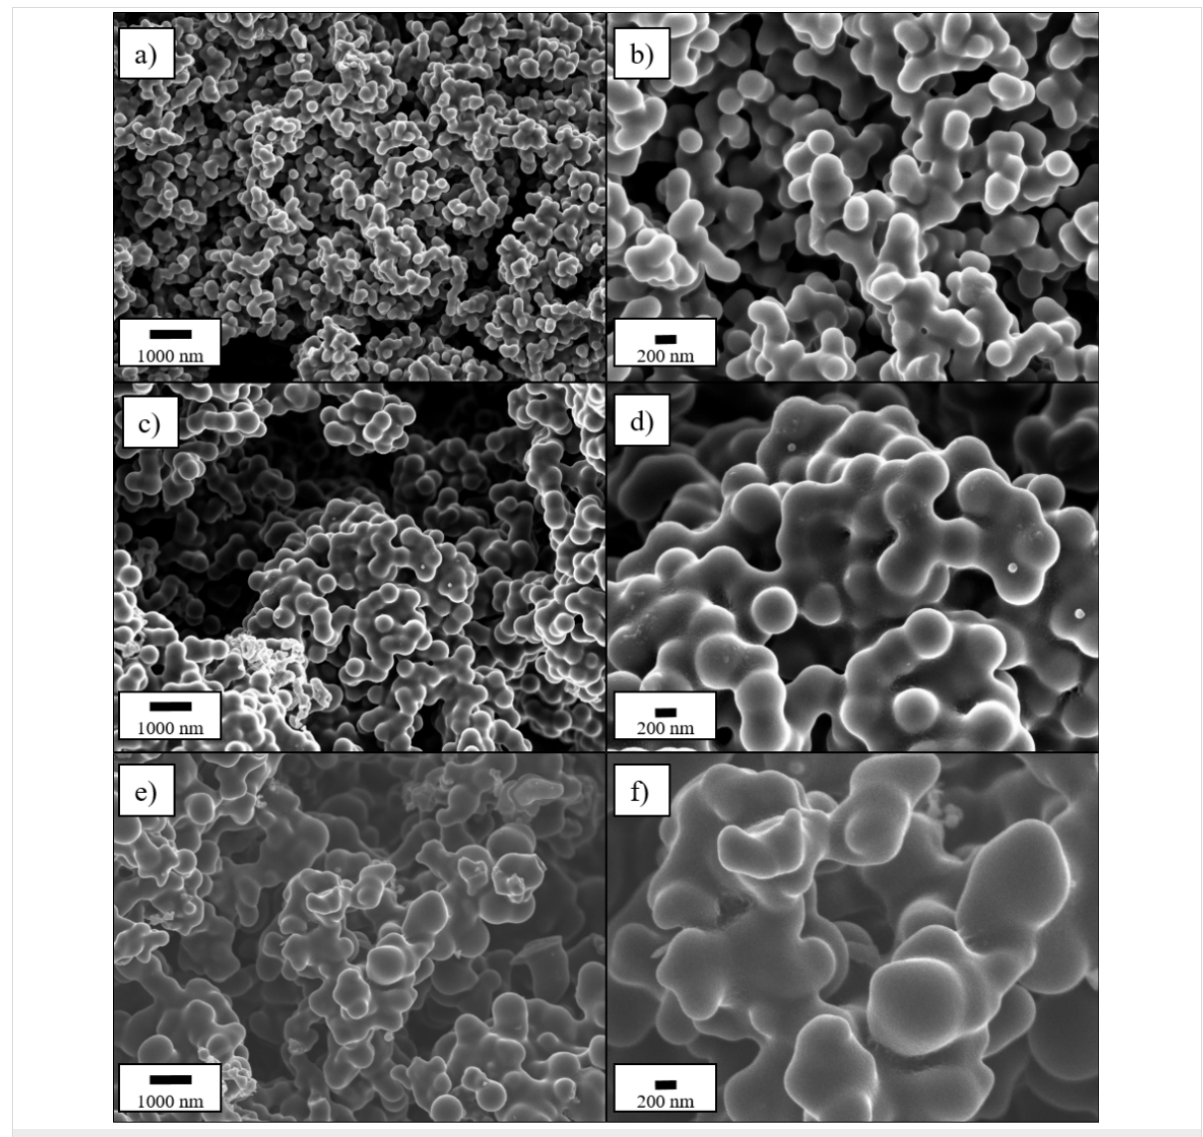
Figure 1: SEM micrographs of the different synthesized Si/C composite materials with a carbon to silicon ratio of 100:0 (a, b), 90:10 (c, d) and 80:20 (e, f) in a magnification of 10k× (a, c, e) and 25k× (b, d,